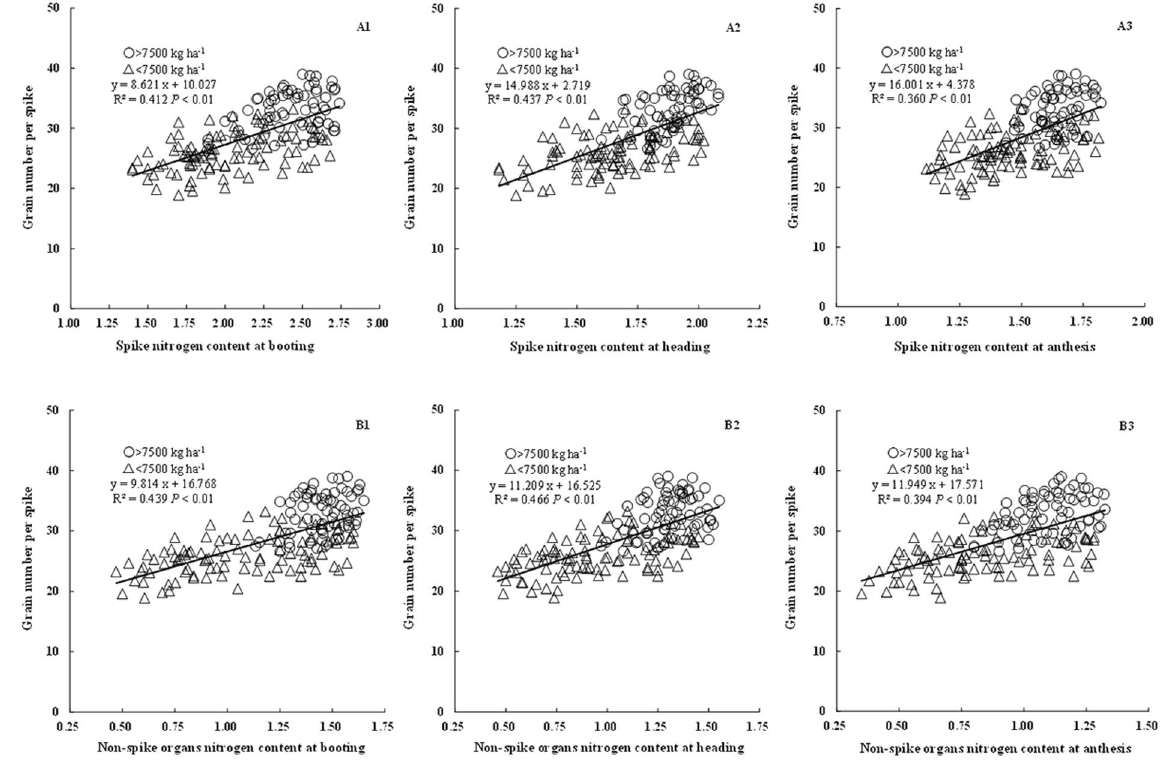
Figure 3. Relationship between grain number per spike and the N content of spike and non-spike organs at different phases before